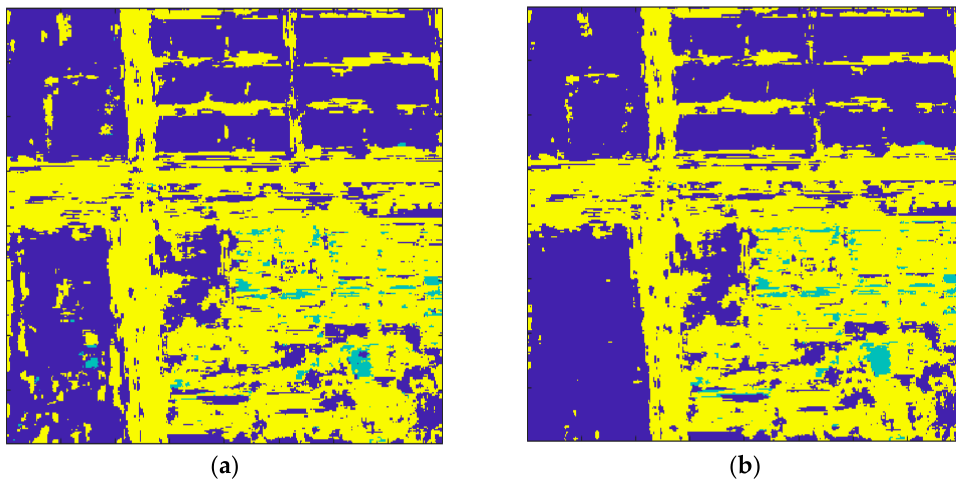
Figure 11. ( a ) Modified average approach result of Dongying City Dataset. ( b ) Our method result of Baotou City Dataset.